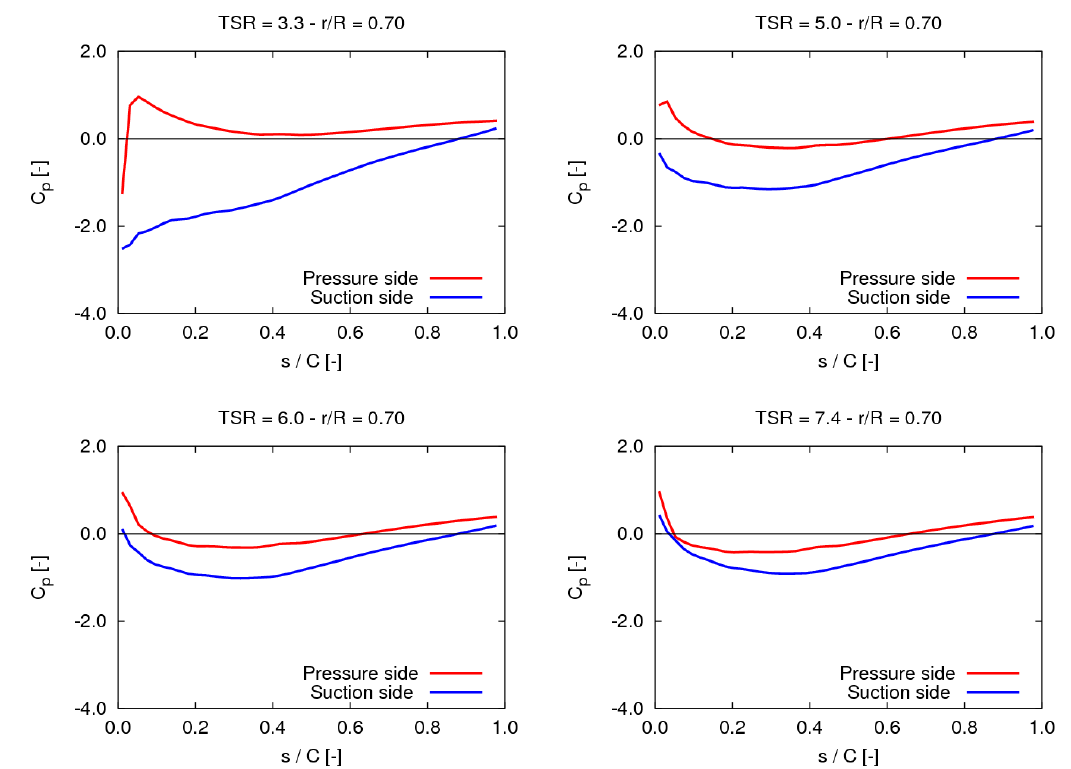
Figure 14. IFREMER-FP turbine. Pressure distribution evaluated by inviscid-flow BIEM at radial section at 70% of blade span. From top left to bottom right : TSR = 3.3, 5, 6,